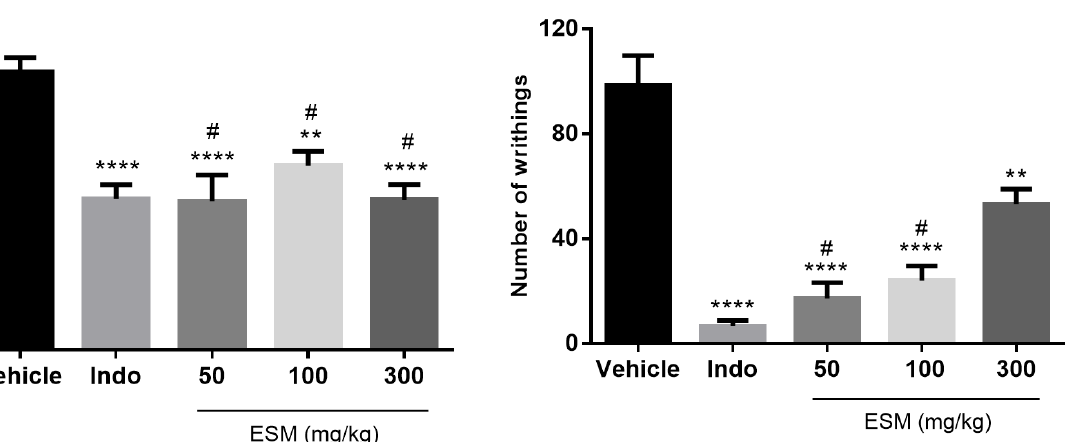
Figure 5. Topical effect of different doses of ESM on croton-oil-induced ear edema in mice. The vehicle, indomethacin 10 mg/kg, and ESM 50, 100, and 300 mg/kg were administered orally 60 min before topical application of 2.5% croton oil diluted in acetone. The weight difference between the right (inflamed) and the left (non-inflamed) ear biopsies was used to measure edema and, consequently, the inflammatory process. Each column’s values represent the mean±S.E.M. ANOVA followed by the Tukey test, used as post hoc . Significant values:** p < 0.01 and **** p < 0.0001 compared to the vehicle group; # means statistically equal to the reference drug (indomethacin).